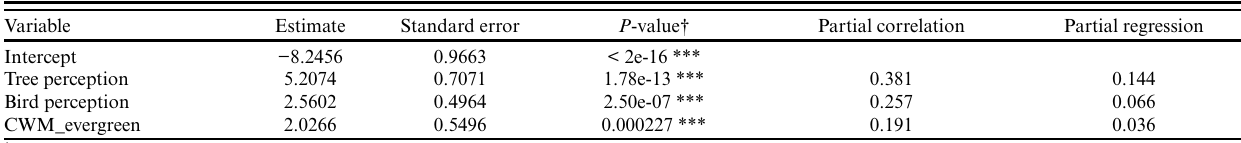
Table 5. Generalized linear model for biodiversity perception (scaled variables). CWM_evergreen = community weighted mean of evergreen species.